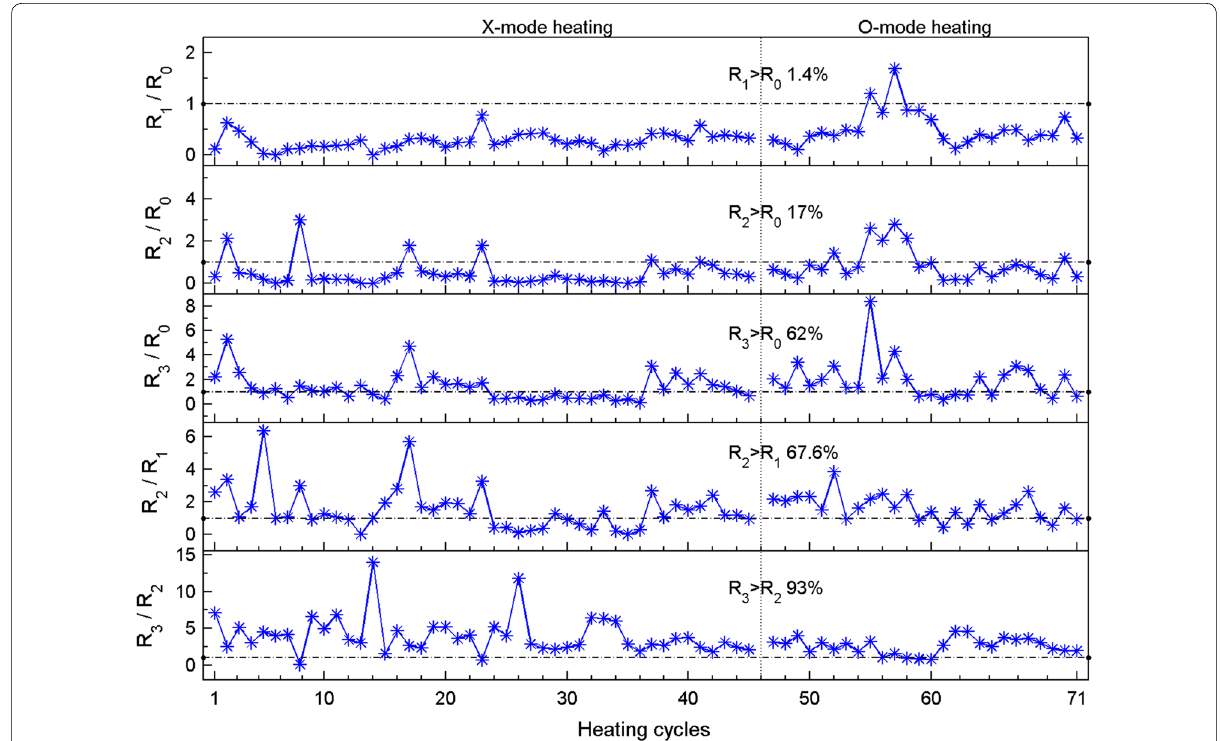
Fig. 6 As for Fig. 3 but for case 3b. In this case, the HF transmitter was operated with one frequency 5.423 MHz